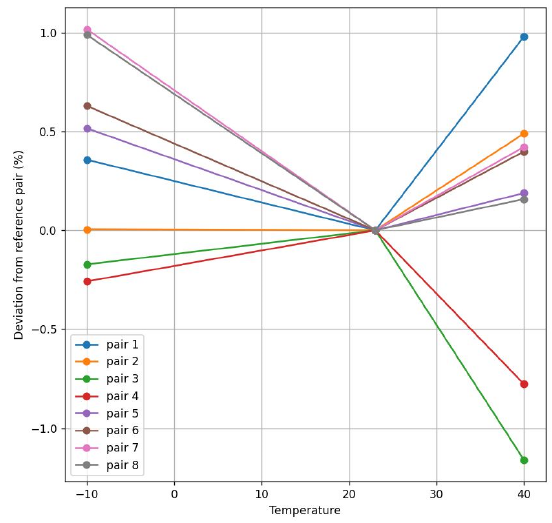
Figure 14. Flow deviation between 200 kHz pairs at 560 L/h.